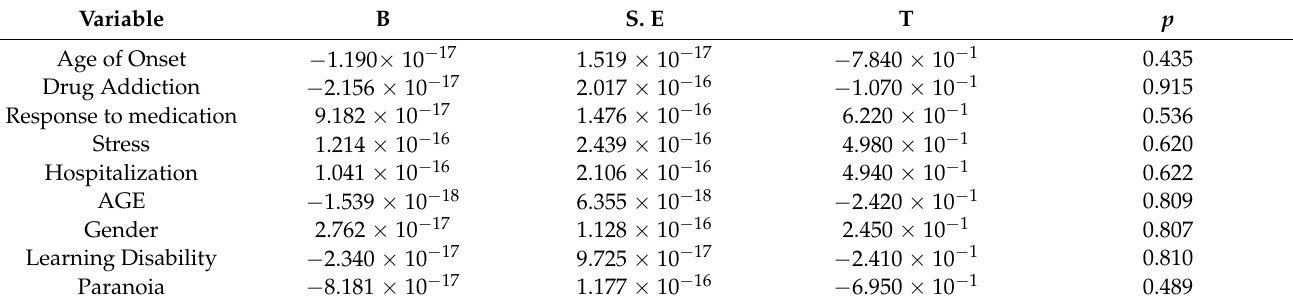
Table 3. Multivariate regression model to show association between family history of schizophrenia and sociodemographic parameters.